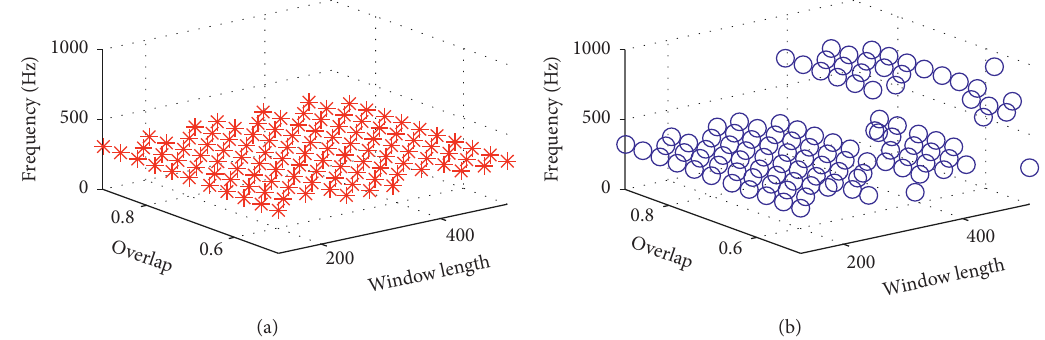
Figure 3: ICFs located by the proposed method and EFS of the simulated signal in Figure 2(b). (a) Envelope negentropy. (b) Energy fluctuation.